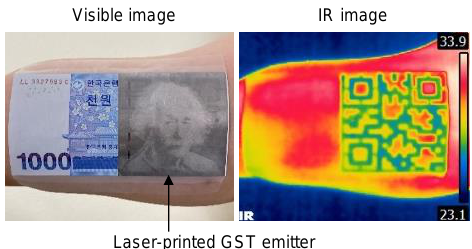
Fig. 2. Visible and IR images of a GST emitter fabricated on a Korean